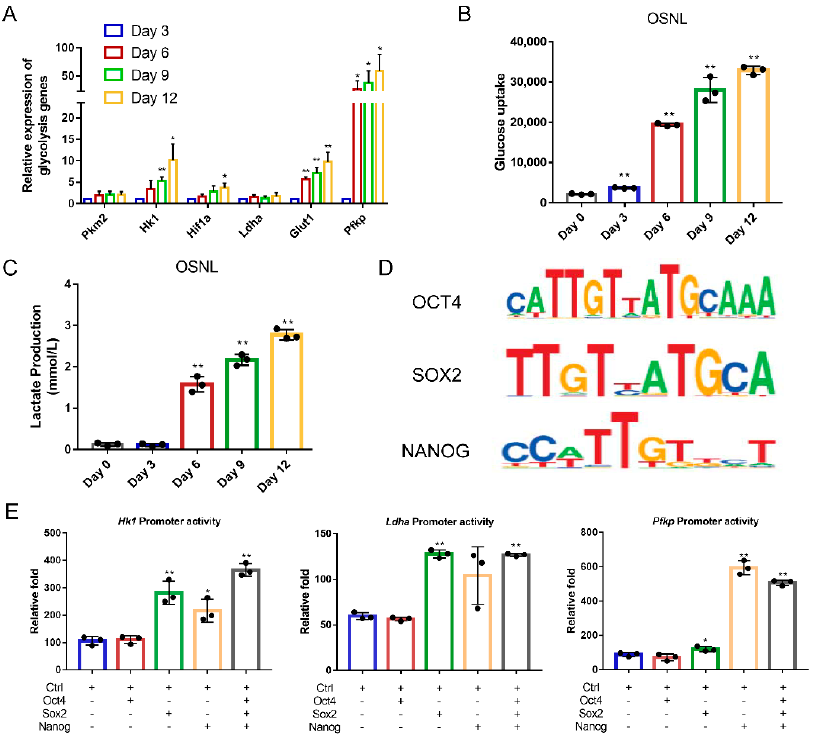
Figure 3. Exogenous OSNL factors activate glycolysis. ( A ) qRT-PCR analysis of expression of glycolysis-related genes in CEF transduced with OSNL reprogramming cocktail. ( B , C ) Changes in glucose uptake and lactate production were determined in OSNL reprogramming cocktail transduced CEF. ( D ) Transcription factor binding motif. The binding motifs of transcription factors OCT4, SOX2 and NANOG were searched on the website (http://jaspar.genereg.net/ (accessed on 30 January 2021)), and the promoter sequences of key genes for glycolysis were searched on NCBI (https://www.ncbi.nlm.nih.gov/ (accessed on 30 January 2021)). After comparing the binding motif of Oct4, Sox2 and Nanog with the promoter sequences of glycolysis key genes, three common target genes, Hk1 , Pfkp and Ldha , of the transcription factors OCT4, SOX2 and NANOG were discovered. ( E ) Co-transfect Oct4, Sox2 and Nanog overexpression vectors with Hk1 , Pfkp and Ldha dual luciferase reporter vectors, respectively, into DF-1 cells. Luciferase activity was detected by a dual luciferin detection kit, normalized to control cells. * represents p < 0.05 and ** represents p <